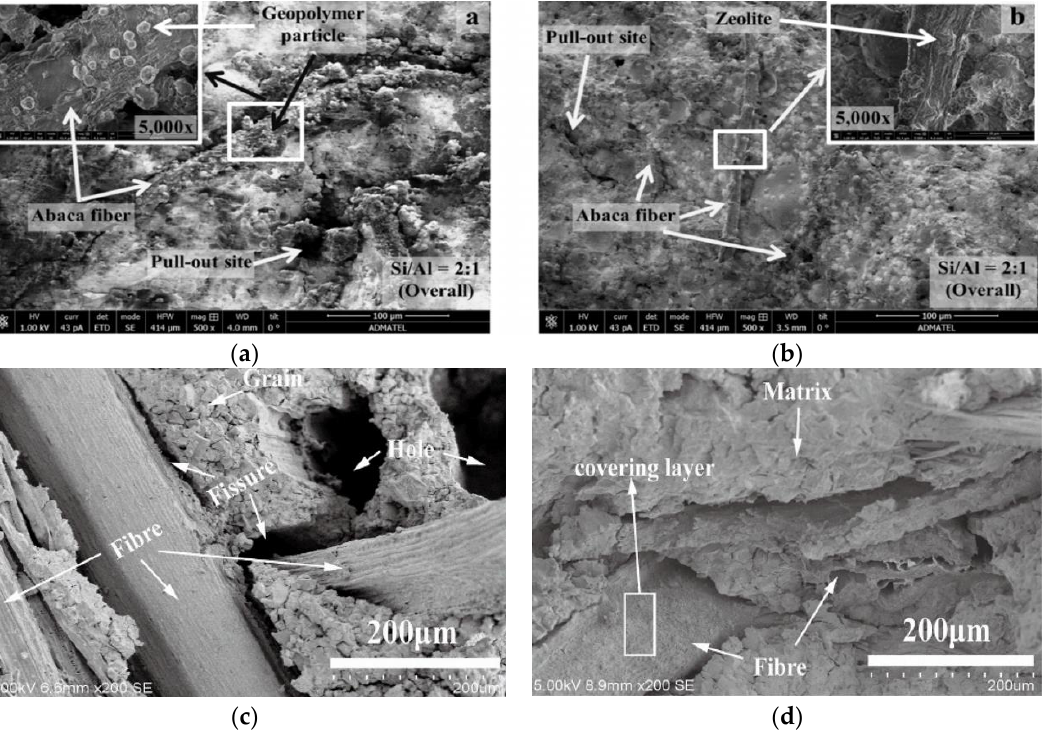
Figure 15. SEM images of composite fractured surfaces: ( a ) reinforced with untreated abaca, ( b ) Treated abaca [119], ( c ) Untreated straw, ( d ) Treated straw [118].